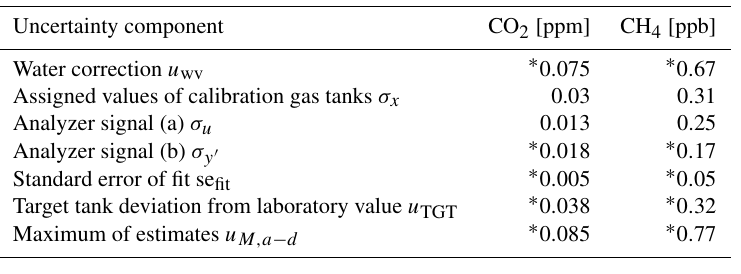
Table E1. Measurement uncertainty components. The nomenclature follows Andrews et al. (2014). For time-varying components, averages are reported and denoted with an asterisk (*).